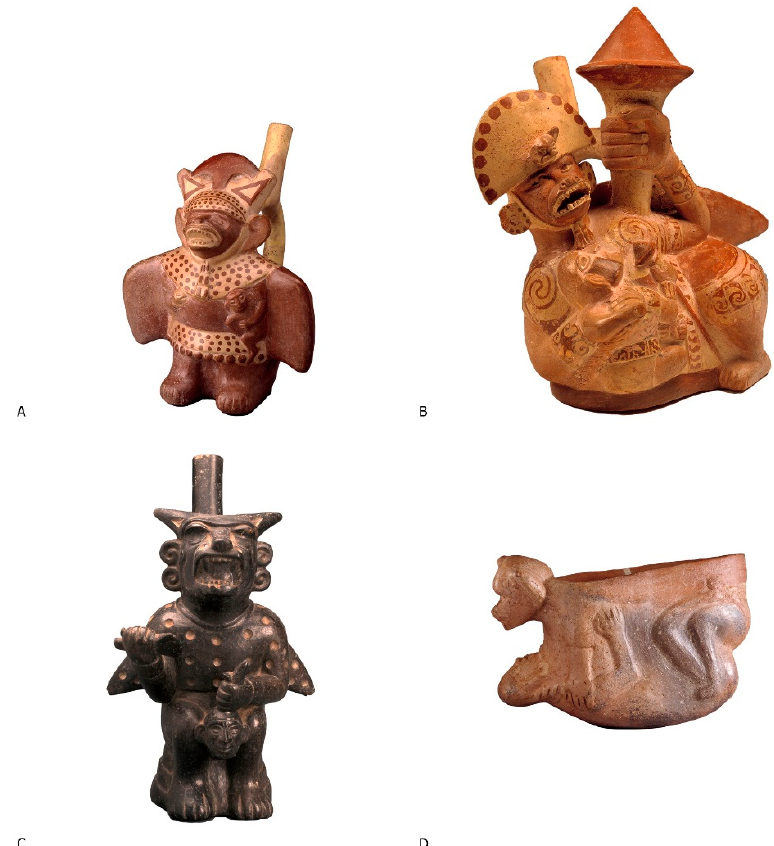
Figure 6. Anthropomorphic bats with human figures and weapons: ( A ) bat figure with tumi -shaped headdress holding a club and person (ML003480); ( B ) large bat figure with half-moon headdress holding a large club and rope tied to a person’s neck (ML003478); ( C ) snarling bat figure with tumi knife and decapitated head (ML010854); ( D ) bat figure on top of a person with earspools (ML004367) (Museo Larco, Lima—Perú).